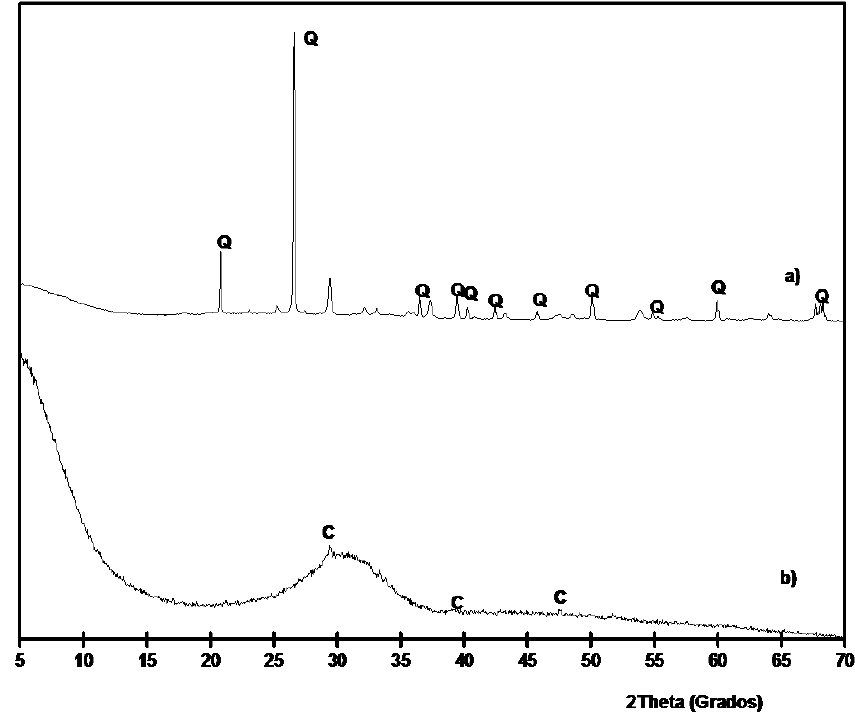
Figure 3. XRD diffractograms for: ( a ) SCBA; ( b ) BFS. (Key: Q: Quartz; C: